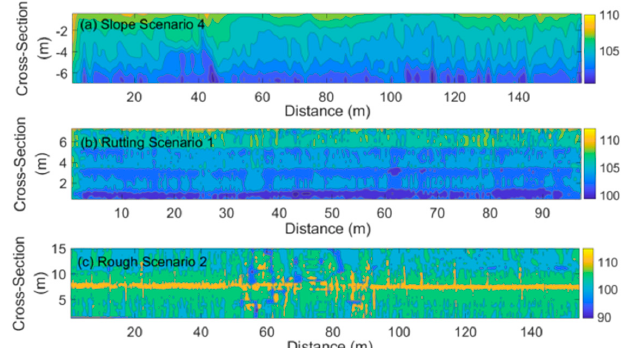
Figure 17. Hydroplaning Speed Estimation using the USF model. ( a ). Hydroplaning speed distribution on the slope scenario 4; ( b ). Hydroplaning speed distribution on the rutting scenario 1; ( c ).